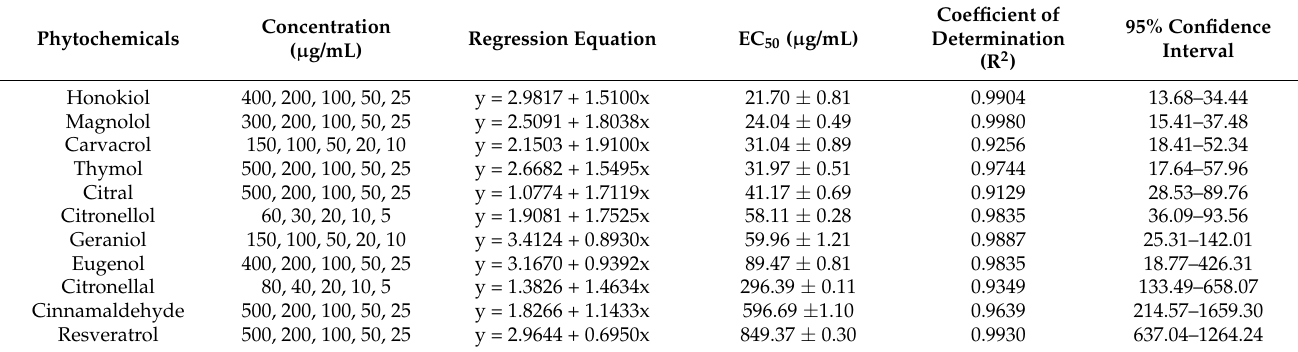
Table 3. Antimicrobial activity of phytochemicals against strain 022ZW.